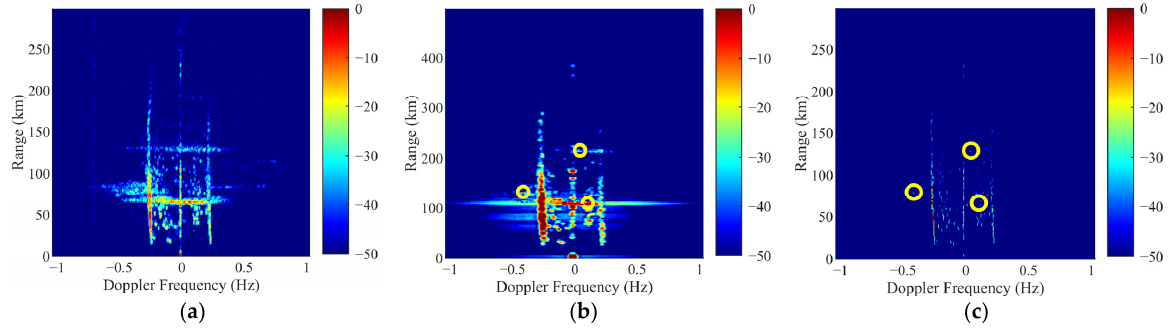
Figure 9. The suppression results in specular reflection ionosphere clutter. ( a ) Original RD images; ( b ) the suppression results of the method proposed by Su et al.; ( c ) the suppression results of the proposed